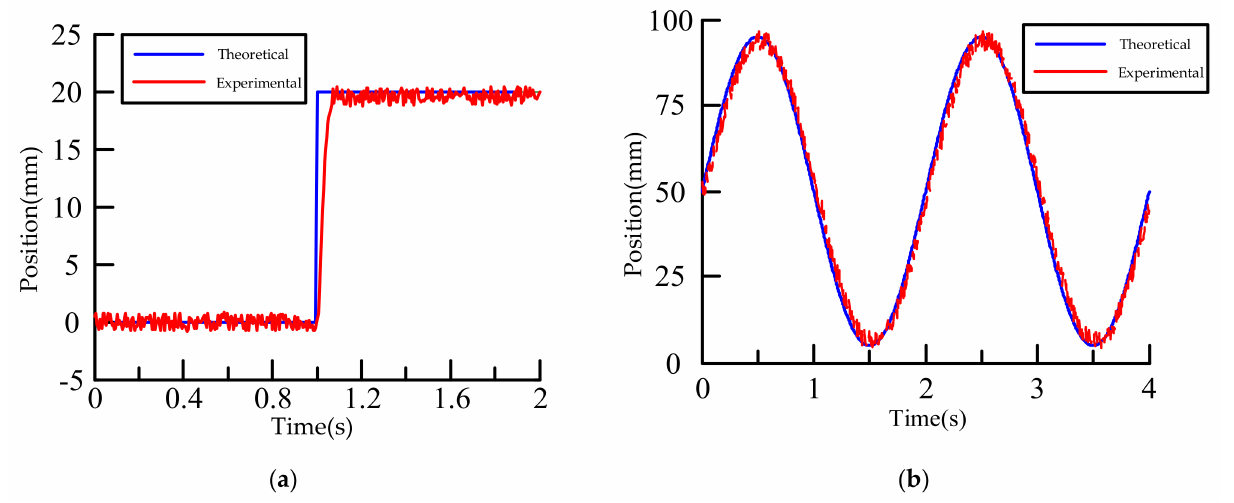
Figure 15. ( a ) Fixed location tracking results; ( b ) sinusoidal trajectory tracking results.